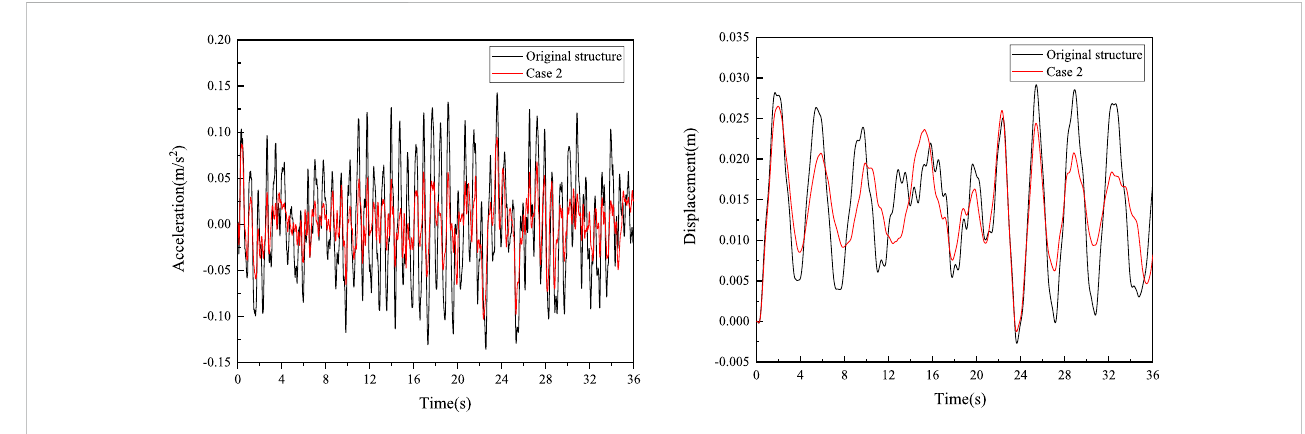
FIGURE 12 The acceleration and displacement control effectiveness when stiffness ratio is .8 under random ice force.